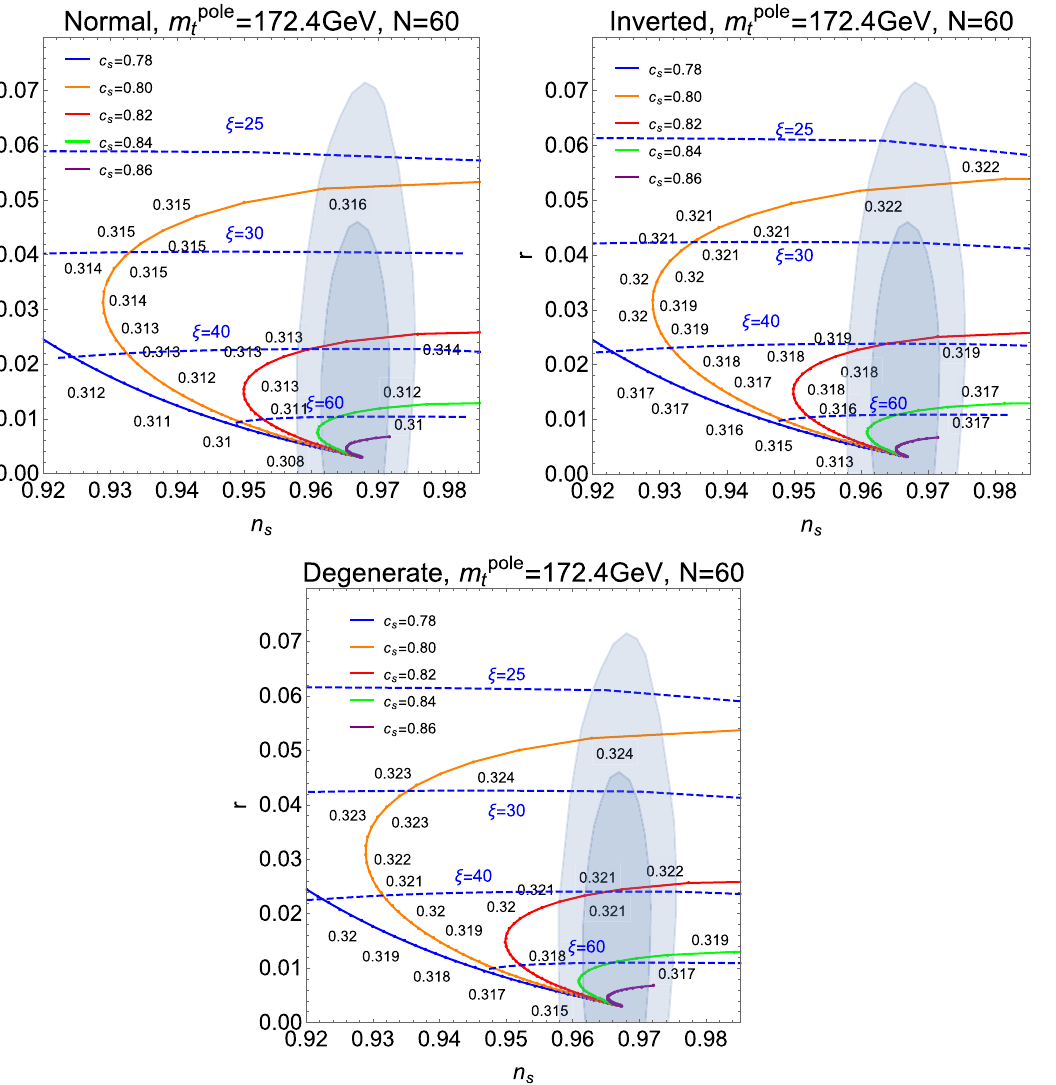
Fig. 6 Upper Left (Right): r vs n s in the case of the normal (inverted) hierarchy where c (ξ) is fixed on each solid (dashed) curves and λ SH ( M t ) is varied. The blue regions correspond to the allowed regions by Planck 2018. Lower: the degenerate